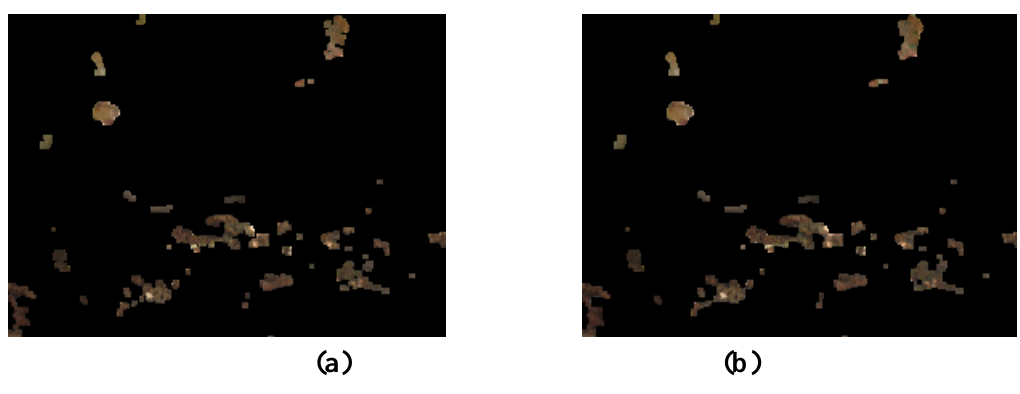
Figure 14. Image of Figure 12(b) after morphological operations with a squared structuring. (a) After the closing operation. (b) After the opening